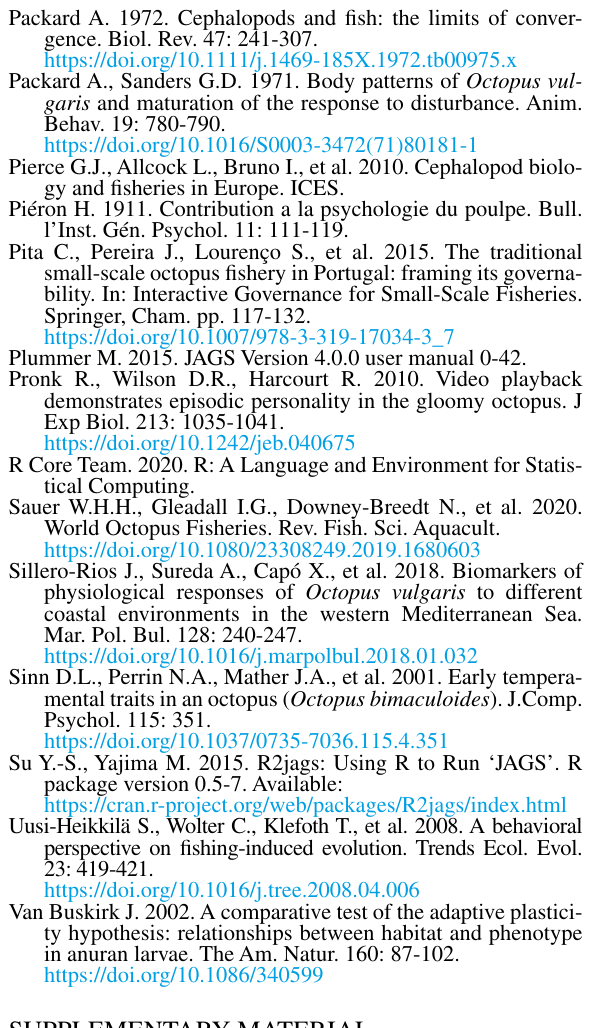
Fig. S1. – Distribution of the Octopus score “posteriors” to first capture (see Eq. 1). The red dot shows the median (or per- Table S1. – Distribution of the main parameters “posteriors” on estimated repeatability and mean latency to first capture (see